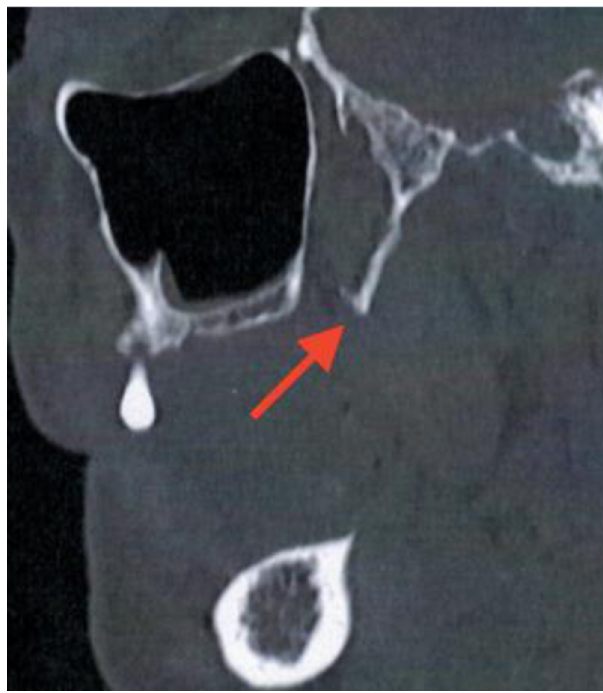
Fig. 2. Hypertrophy of the pterygoid hamulus (red arrow) on the computerized tomography (cid:1) scan (para-sagittal